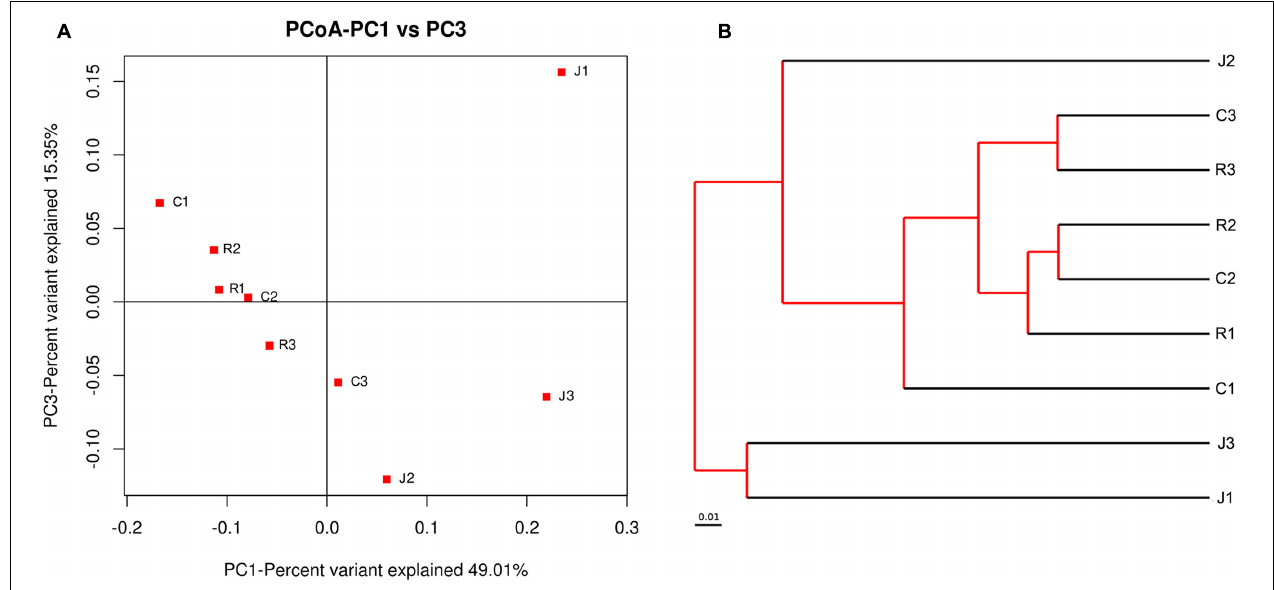
FIGURE 1 | Differences in bacterial community structures and relationship between all of the samples. (A) Principal Coordinate Analysis (PCoA) of bacterial community structures of the gut microbiota of the three sample groups. Each symbol represents each gut microbiota. PCoA shows distinct bacterial communities between different samples. (B) The UPGMA tree analysis of samples in